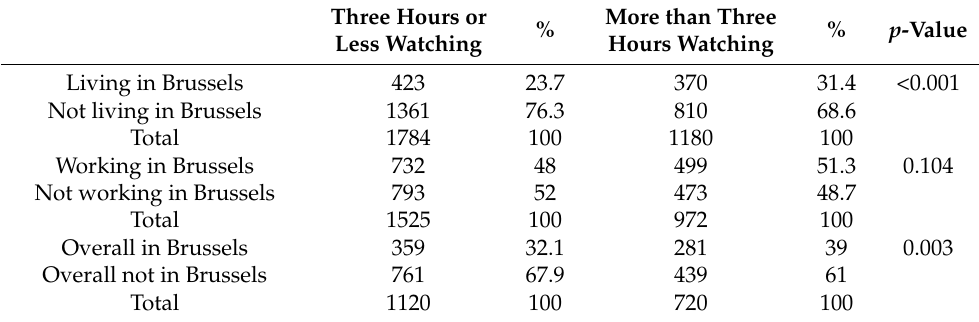
Table 5. Overlapping media watching and proximity (column